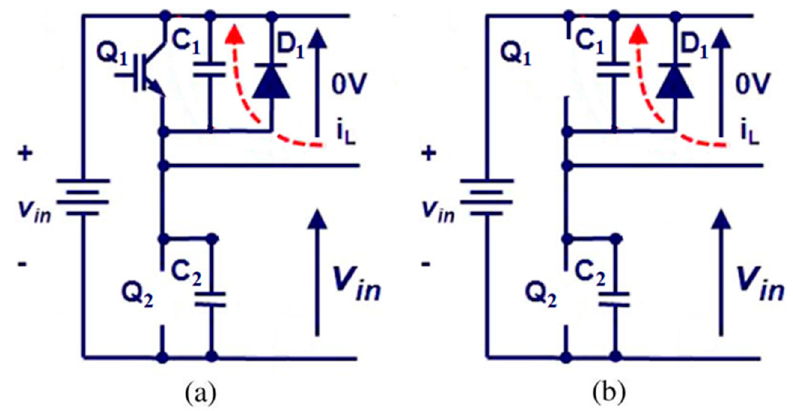
Figure 6. ( a ) Initially Q 1 is ON and Q 2 is OFF. In this case, Q 1 is ON but current flows through D 1 ; ( b ) during switching, Q 1 switches OFF before Q 2 switches ON. C 1 and C 2 continue to have 0 V and V IN respectively across their terminals. When Q 2 is turned ON, diode D 1 will be forced OFF, C 1 will be charged up to V IN and C 2 will be fully discharged.